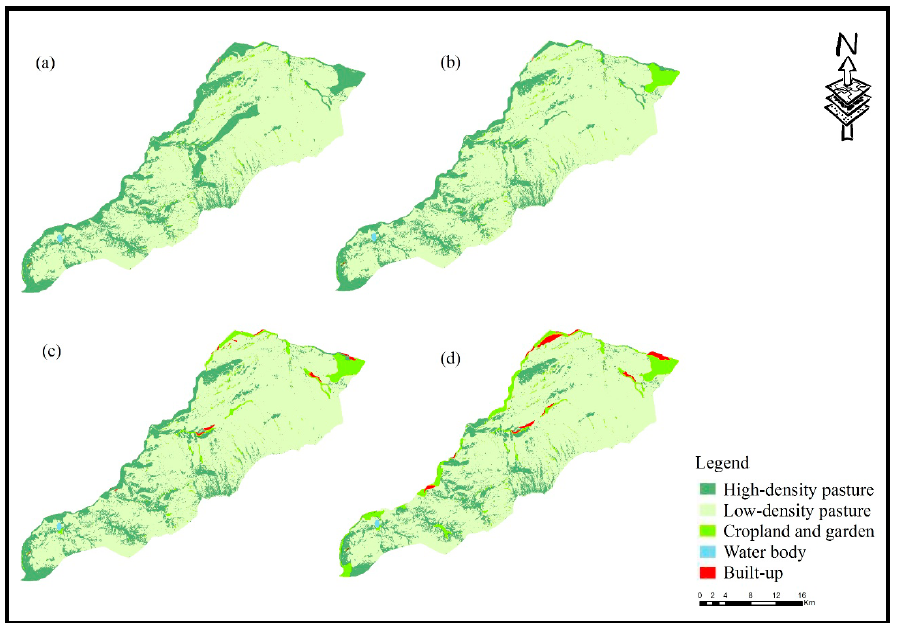
Figure 4. LULC changes for the Kavdeh Wildlife Reserve, Iran: ( a ) 1989, ( b ) 1999, ( c ) 2009, ( d ) 2019.